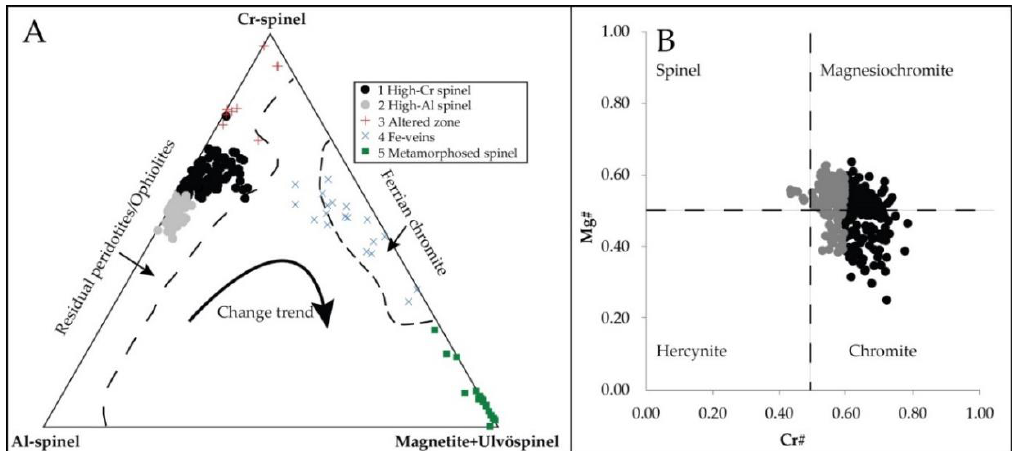
Figure 6. ( A ) The Cr-Al-Fe 3+ ternary diagram modified from [32] with distribution of spinel samples results; ( B ) Cr# vs. Mg# plot modified from [33] with distribution of the analyzed chromian spinels results. Black dots: high-Cr spinels, grey dots: high-Al spinels.